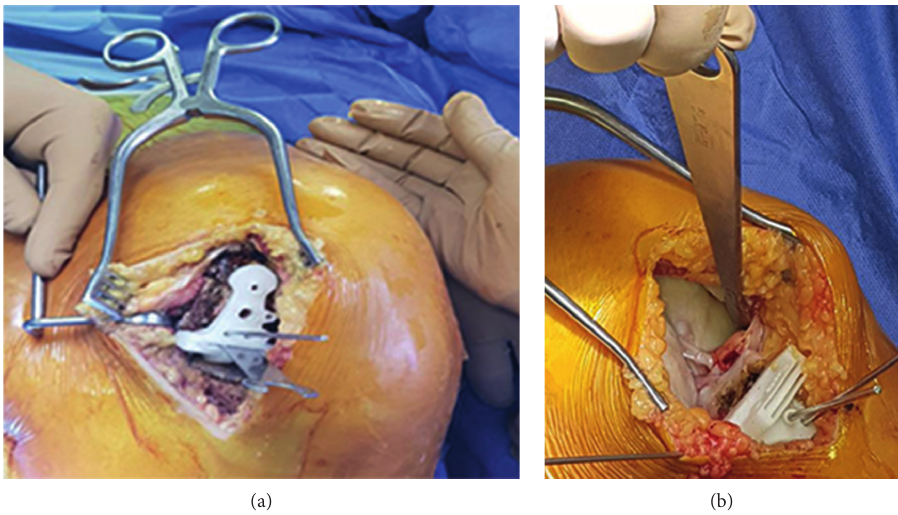
Figure 4: The femoral (a) and tibial (b) components of the UKA patient-specific cutting guides.